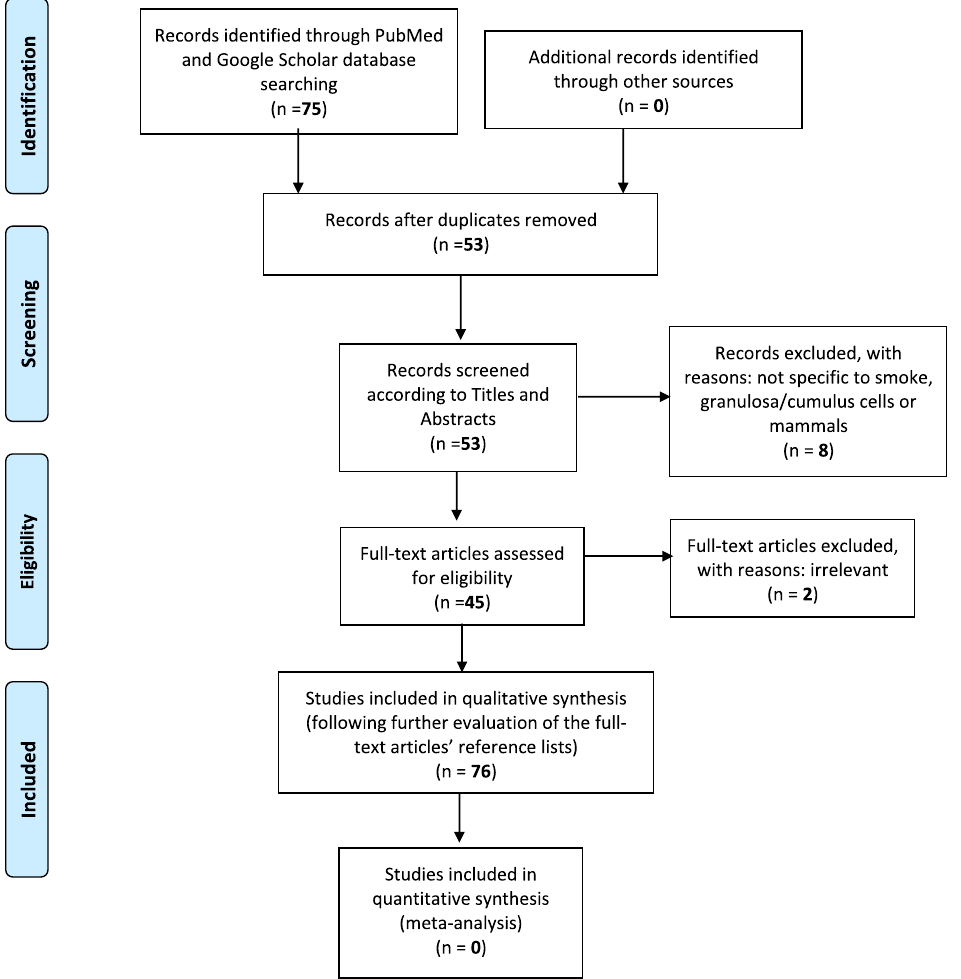
Figure 1. The Preferred Reporting Items for Systematic reviews and Meta-Analyses (PRISMA) flow diagram identifies the total number of articles initially surveyed and the number of articles included and excluded for this systematic review.